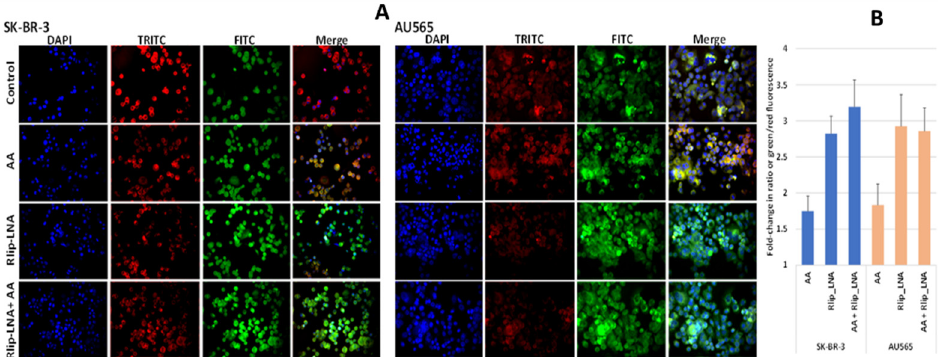
Figure 2. ( A ) In vitro lipid peroxidation with and without AA and Rlip-LNA treatment. Cells were first transfected with Rlip-LNA or the scrambled control (CAS), and after overnight incubation, cells were treated with 100 µM AA or vehicle control. After 24 h, lipid peroxidation was assayed using the ratiometric Lipid Peroxidation Sensor as described in Materials and Methods. Representative images are presented. All images are at 200× magnification. ( B ) Histograms represent the ratio of green to red in both cells.